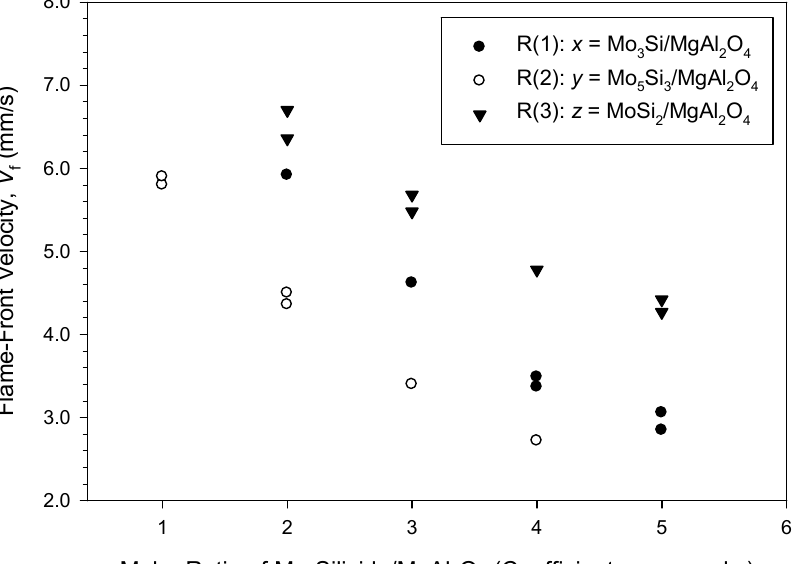
Molar Ratio of Mo-Silicide/MgAl O (Coefficients: x , y , and z ) 2 4 Figure 3. Variations of flame-front propagation velocities with stoichiometric coefficients ( x , y , and z ) of R(1), R(2), and R(3).